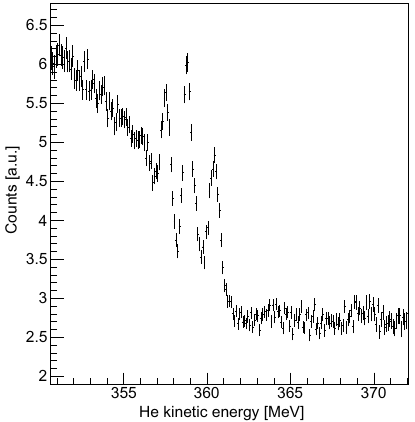
Fig. 3. Measured roughly acceptance-corrected spectrum of the ( d ; 3 He) reaction near the pion-emission threshold. The calibrations of the abscissa is preliminary.